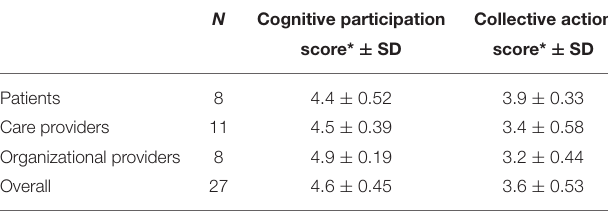
TABLE 5 | Cognitive participation and collective action scores by study group.